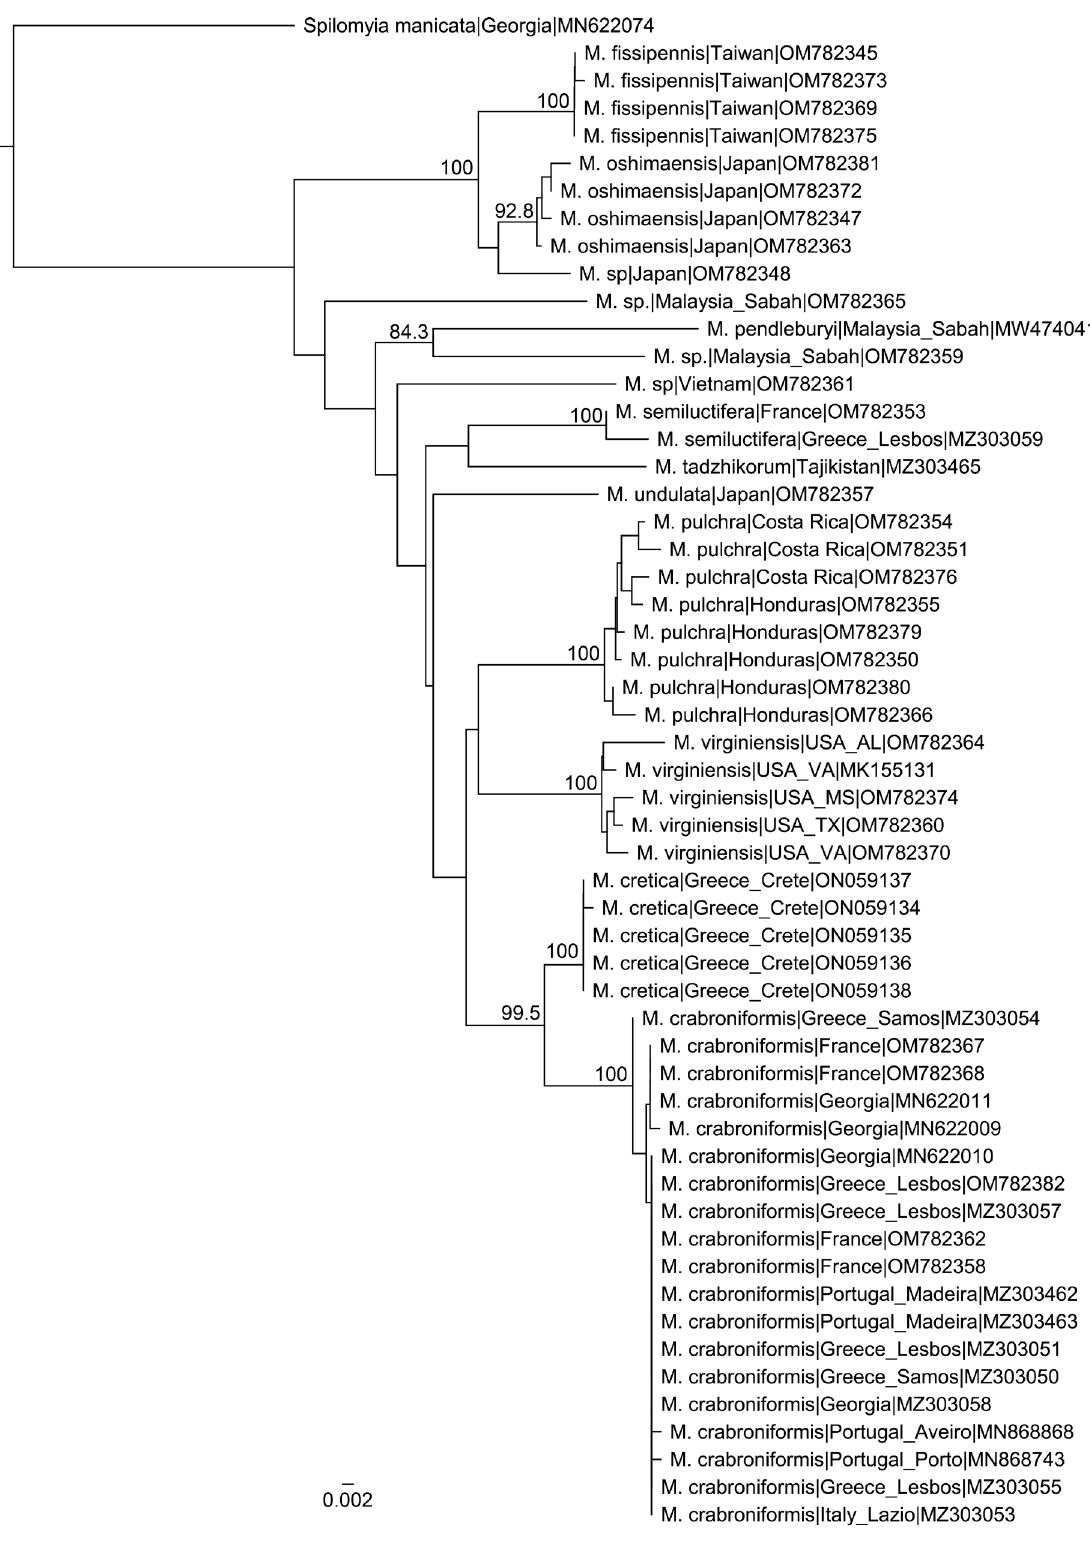
Fig. 9. Neighbour-Joining tree using the 658 bp COI sequences. Numbers at nodes indicate the bootstrap support values above 80. Each specimen name has the morphological identification, the country of origin and the GenBank Accession